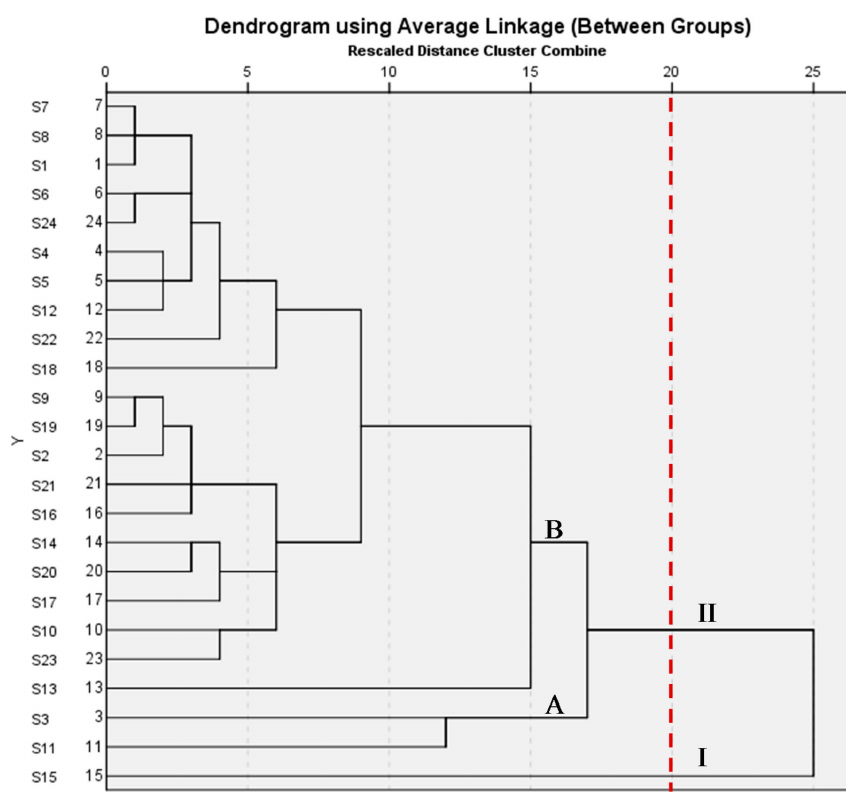
Figure 2. Hierarchical clustering analysis of S. stolonifera samples. The hierarchical clustering analysis (HCA) of samples 1–24 was performed using SPSS statistics software (SPSS for Windows 20.0, SPSS Inc., New York, NY, USA). A method called Between-Groups Linkage was applied. I and II represent cluster I and cluster II, respectively. A and B represent subgroup A and subgroup B,